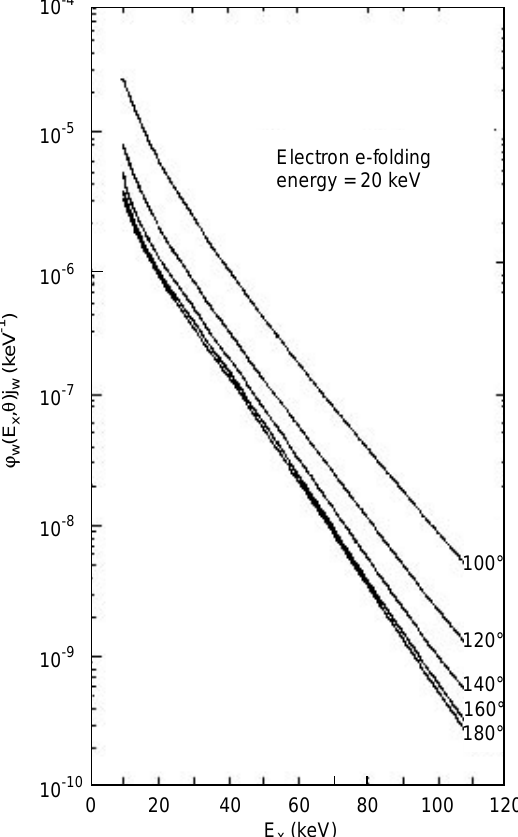
From Fig. 5, we find the X-ray spectrum (cid:85) (cid:133) E emitted in the upward hemisphere from each unit horizontal area of the production layer as a function of electron e-folding energy and normalized to the incident integral electron flux (cid:133) j